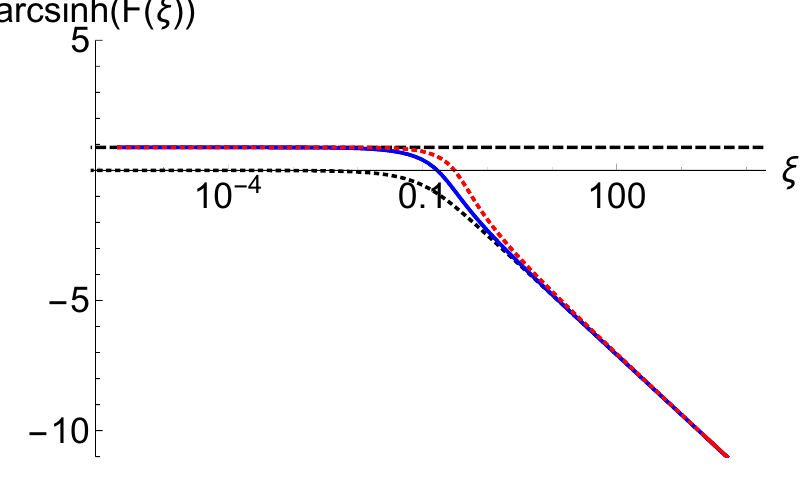
Figure 5 . arcsinh( F ( ξ )) with F ( ξ ) = k ( φ f ) (red, dotted), F ( ξ ) = k ( φ N ) (blue, continuous), F ( ξ ) = 1 (black, dashed) and F ( ξ ) = − 6 ξ (black,